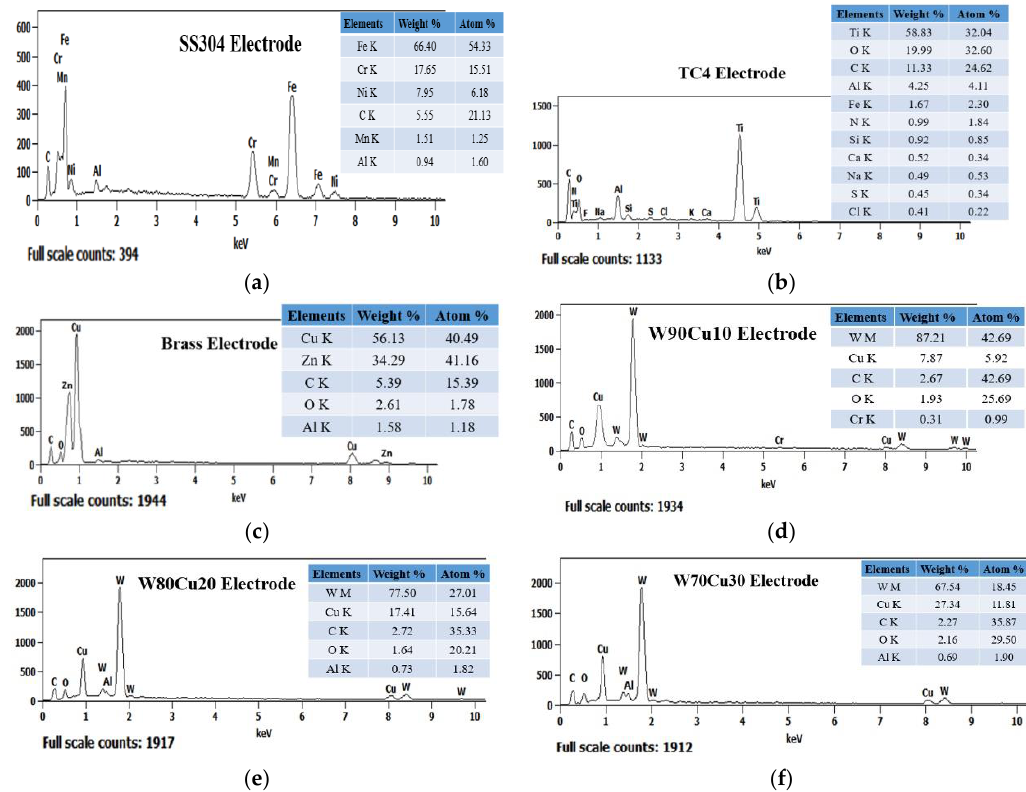
Figure 4. Energy-dispersive X-ray spectroscopy (EDX) spectrum analysis of six electrodes before ECDM: ( a ) SS304; ( b ) TC4; ( c ) brass; ( d ) W90Cu10; ( e ) W80Cu20; ( f ) W70Cu30. Table 1. Properties of the electrode materials.